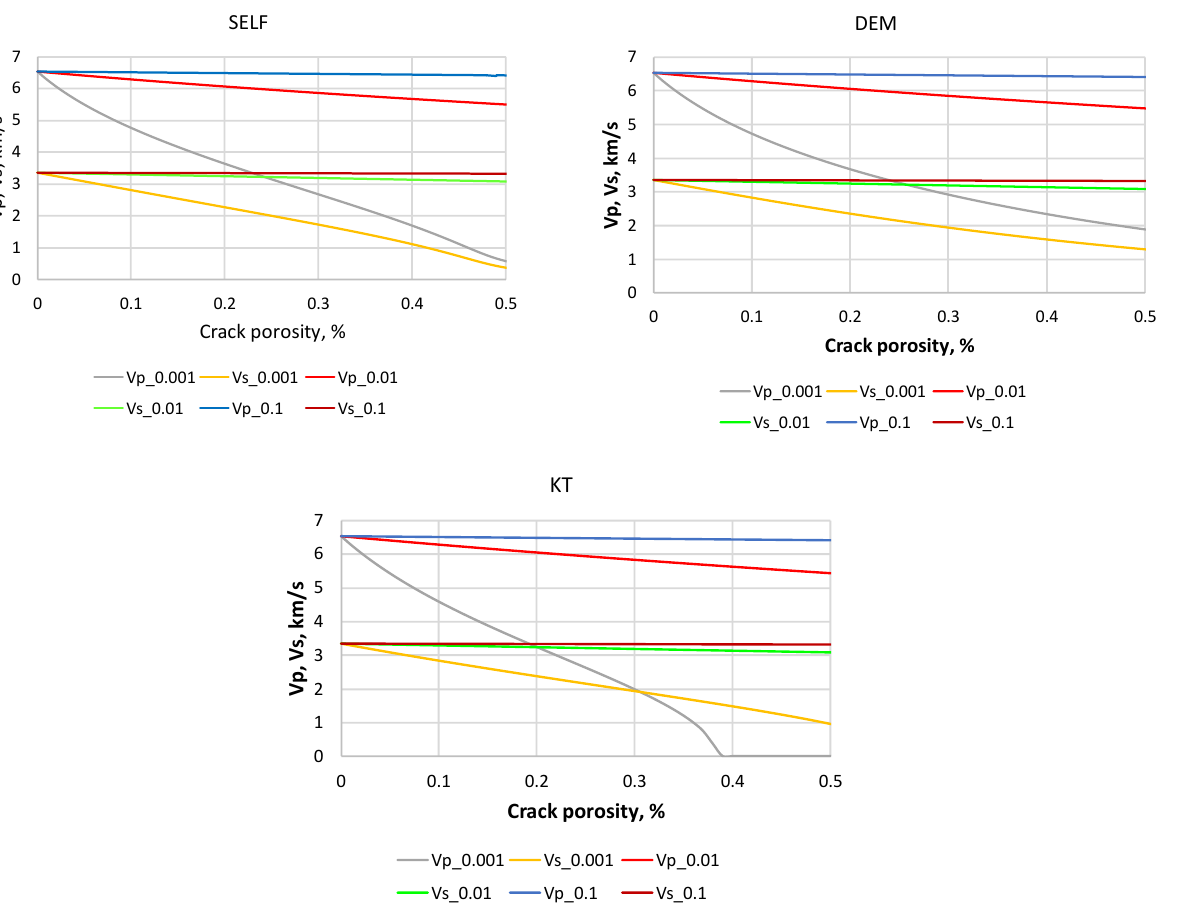
Figure 9. Elastic wave velocities as a function of crack porosity for an isotropic model of a calcite matrix with randomly oriented cracks of various shapes. The numbers in the legend correspond to the aspect ratio of cracks. SCA is the self-consistent method, DEM is the differential scheme, and KT is the Kuster – Toksöz method.